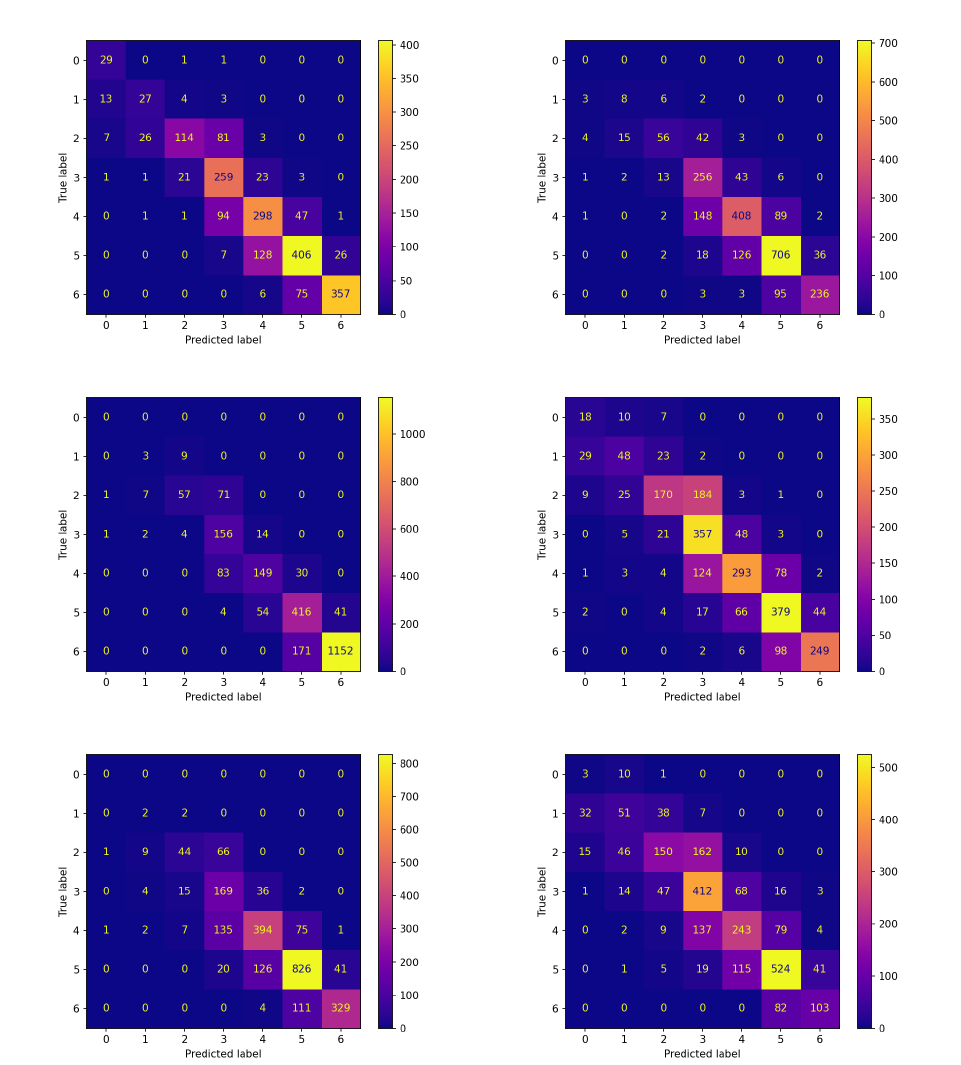
Figure 5. Confusion matrices on the testing set of each patient for the best model (model 575) evolved by FLEA